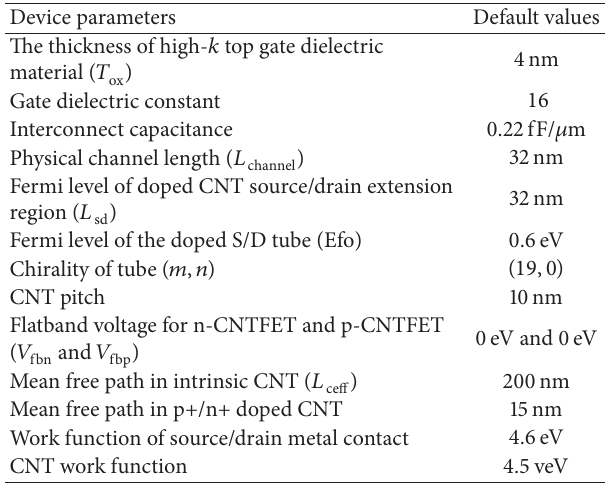
Table 2: Sizing of a CNTFET used for the various SRAM topologies